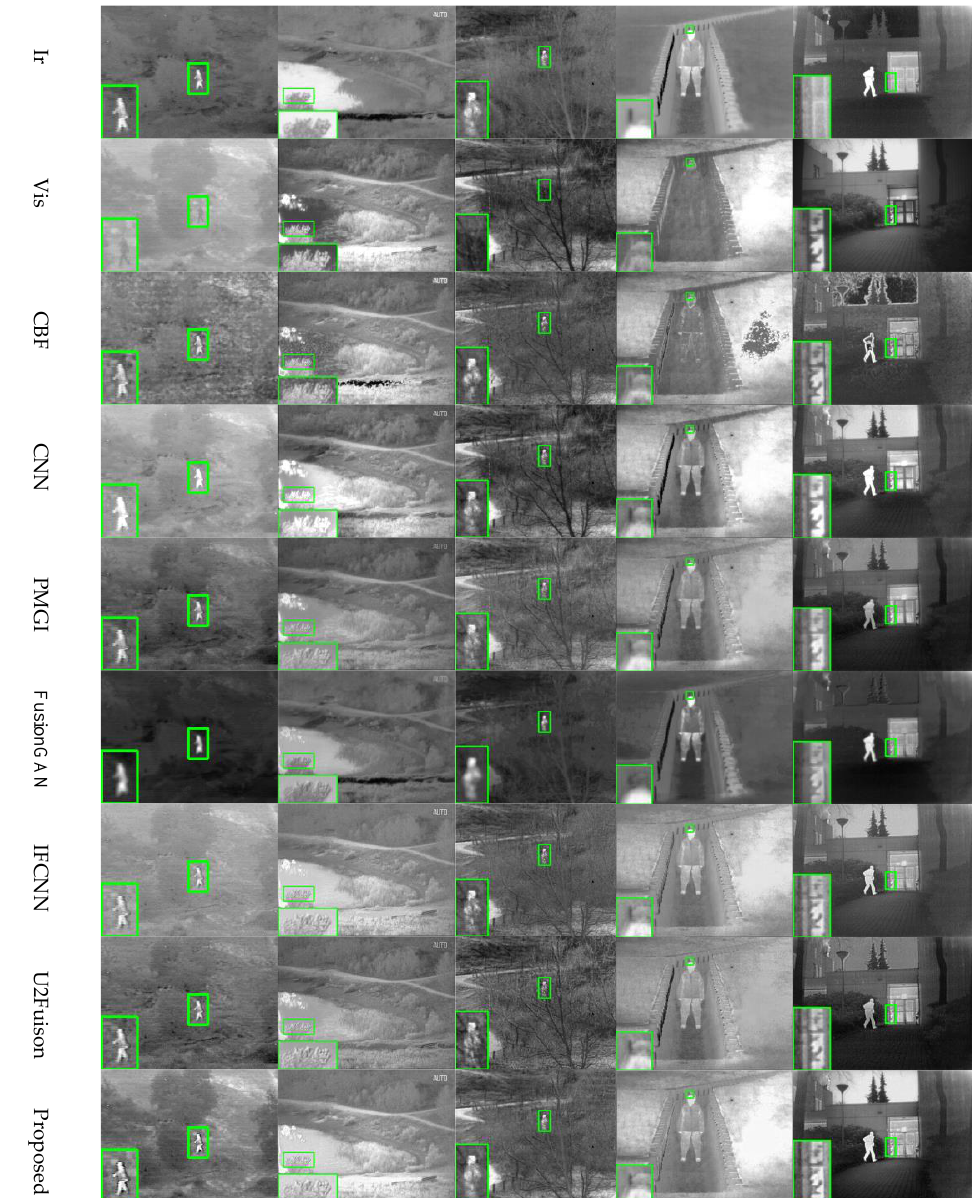
Figure 12. Experimental results of different fusion methods.